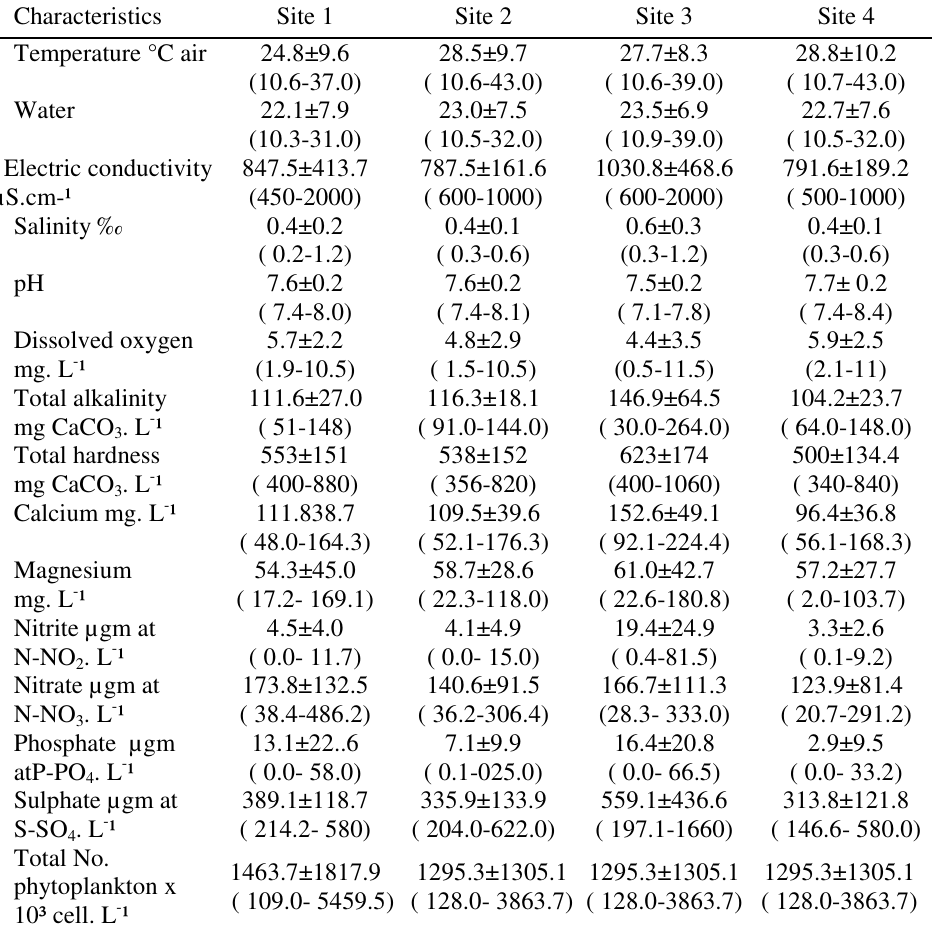
Table 1. Mean ± SD (range) of some physical and chemical parameters and the total cell number of phytoplankton in Shatt